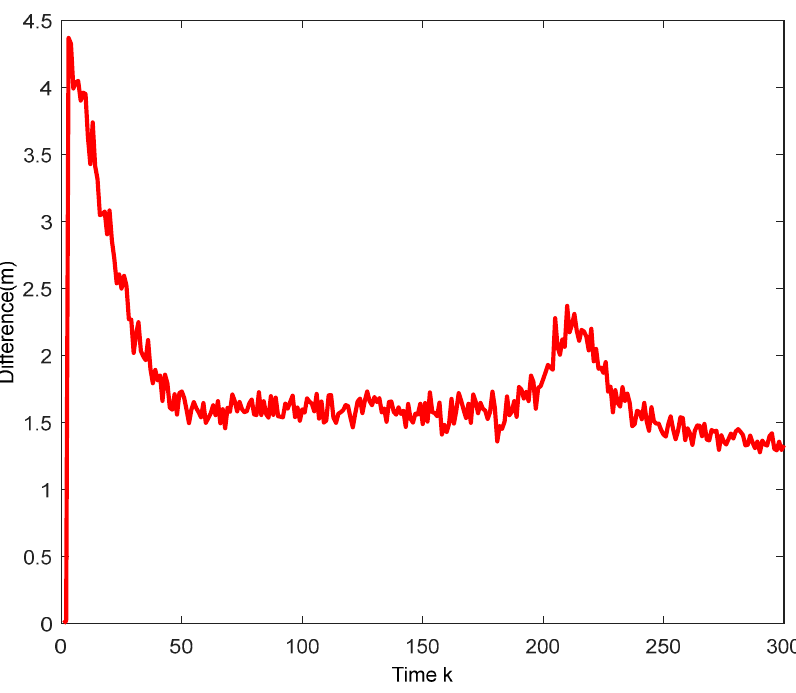
Figure 6. The disagreement between sensors.